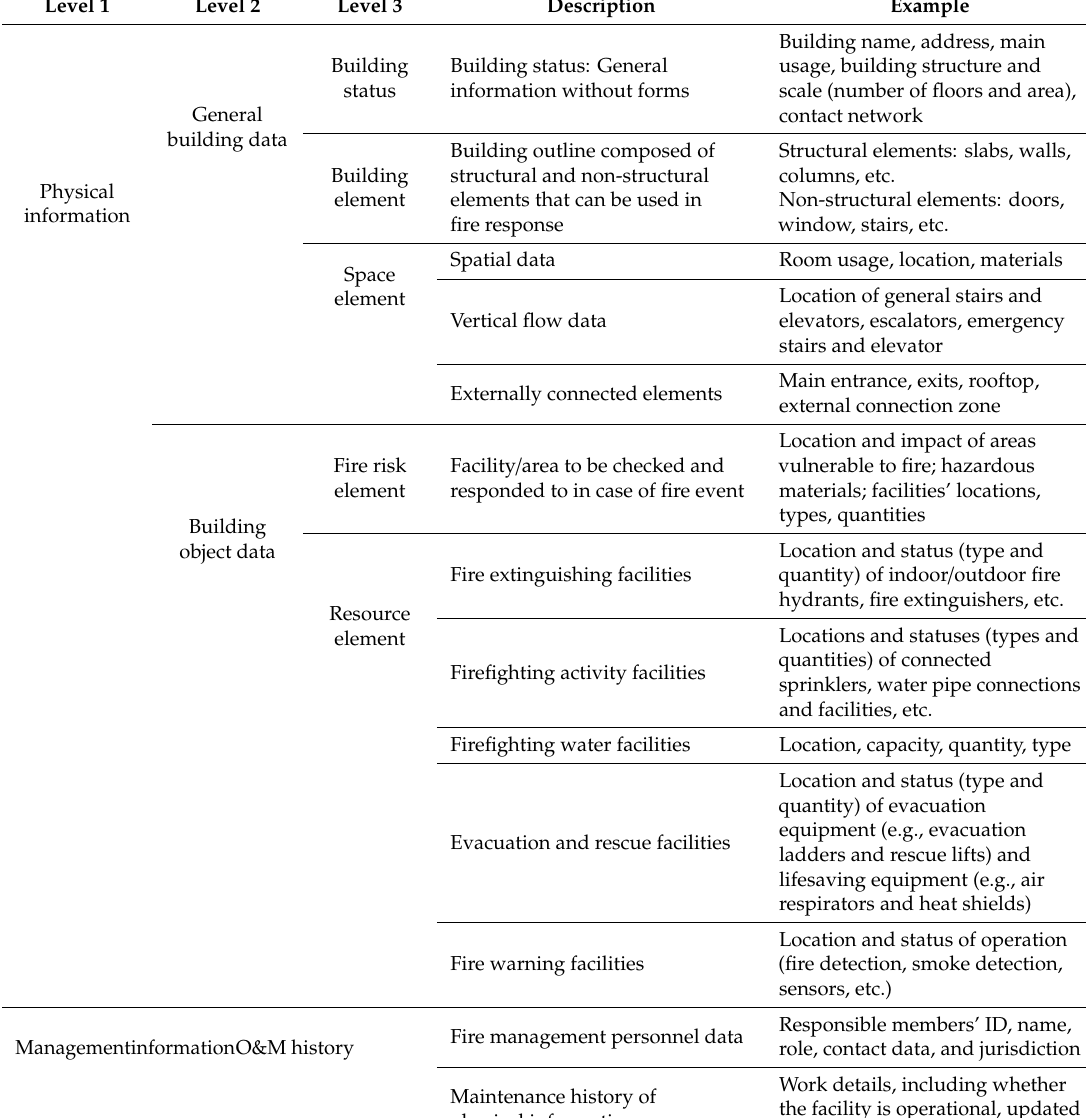
Table 1. Static (non-situational) information breakdown structure for Building Fire Information Management System